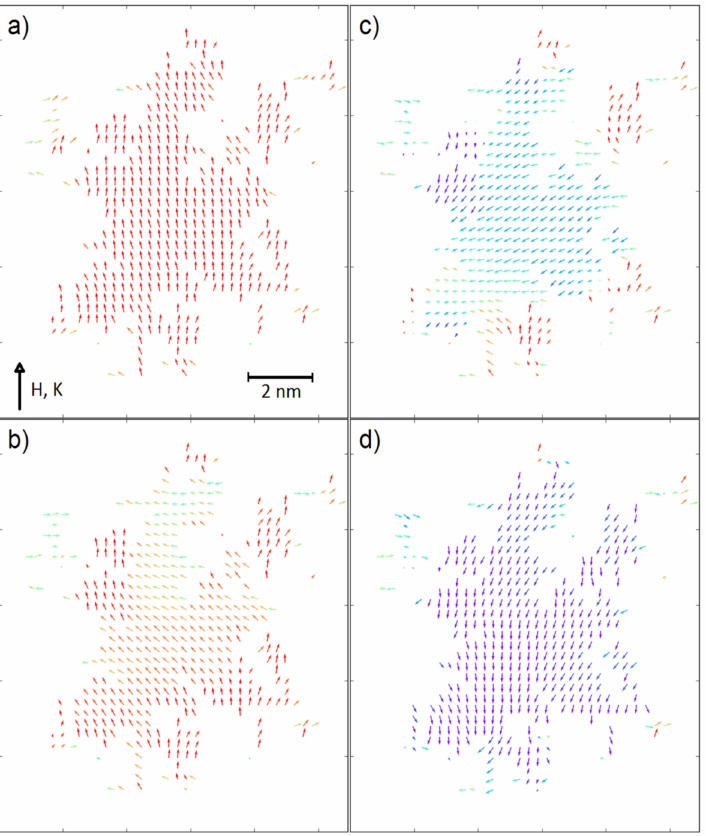
Figure 10. Spin configurations (cross-section) of the system presented in Figure 9 in the external magnetic field equal to ( a ) 1 T, ( b ) 0 T, ( c ) − 0.4 T and ( d ) − 0.6